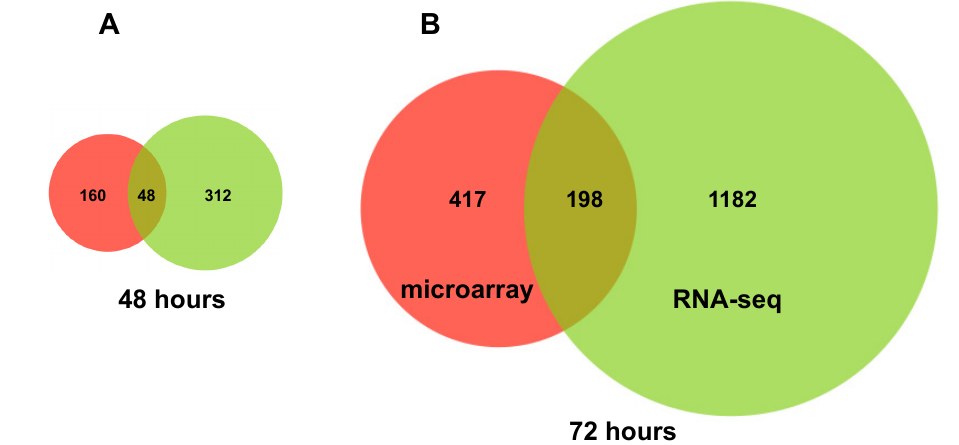
Figure 2. Significantly differentially expressed annotated genes as determined by RNA-seq analysis of 5' capped RNA compared to microarray analysis of poly(A)+ RNA ( p > 0.05 and fold change of  2.0, [9]) after 48 (Panel A) and 72 hours of HCV infection of Huh 7.5 cells (Panel